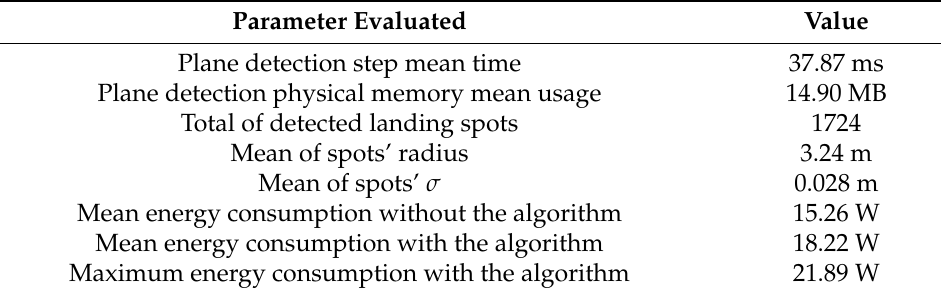
Table 6. Statistics for the experimental dataset.